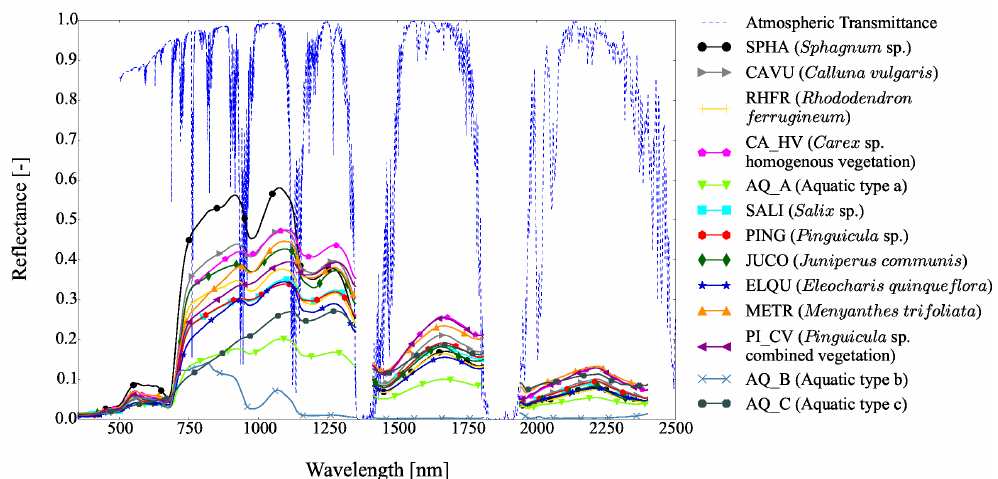
Figure 2. Mean spectral reflectances of the 13 vegetation types and the U.S. Standard atmospheric transmittance.